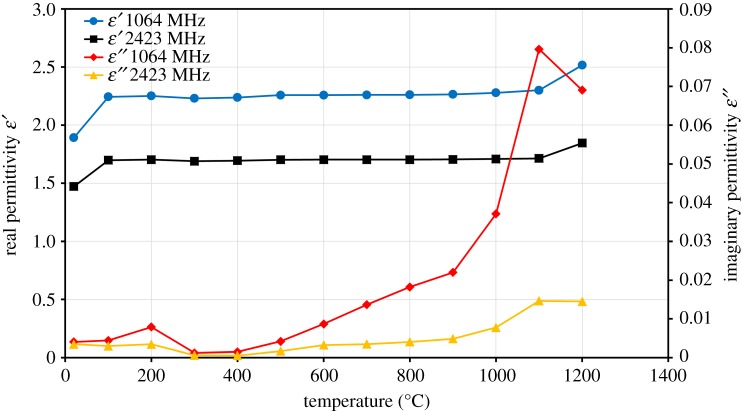
Real (ε′) and imaginary (ε″) permittivities of ZnFe2O4 as a function of temperature at frequencies of 1064 MHz and 2423 MHz.